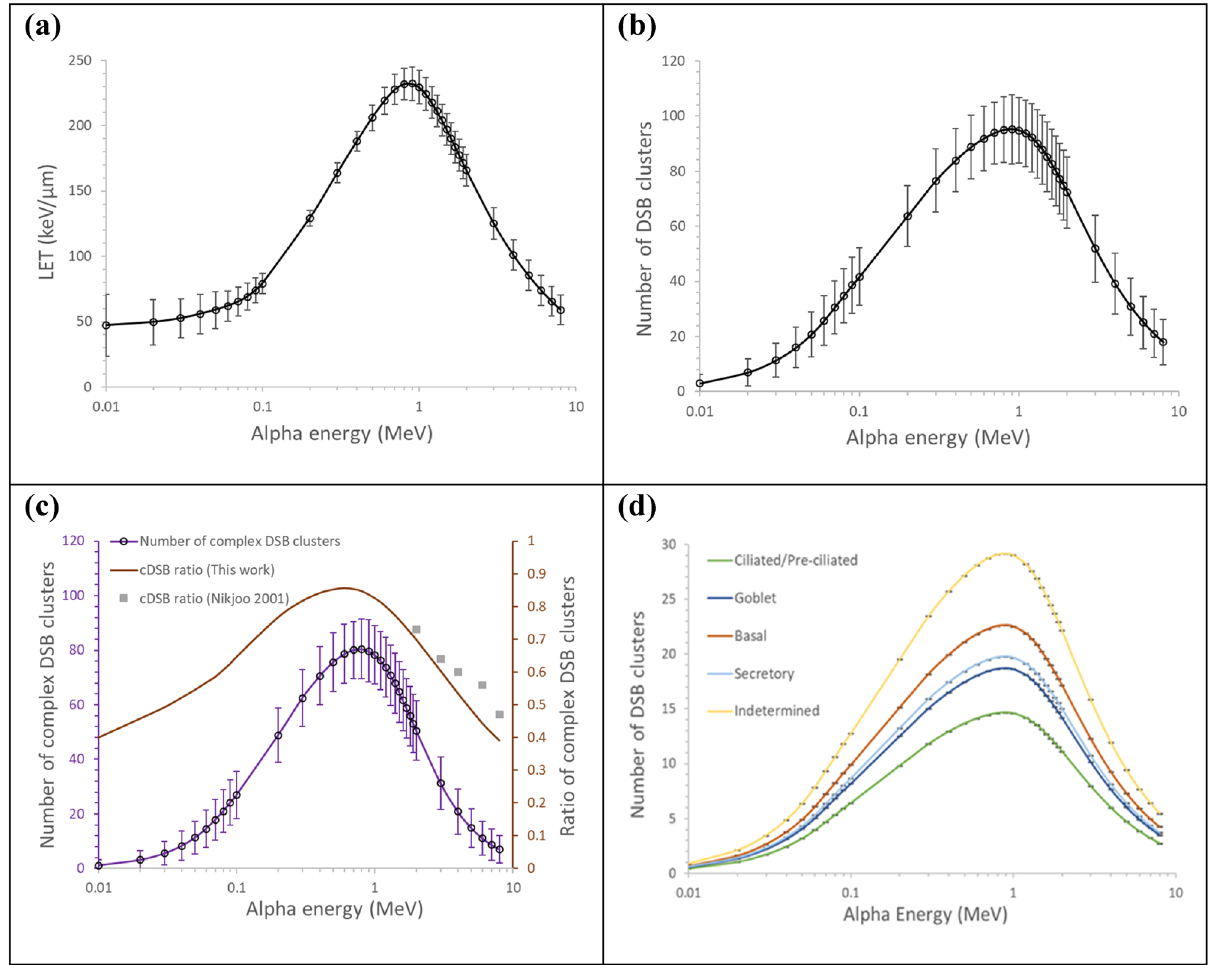
Figure 5. Results from Geant4-DNA simulation of energy deposition events in water medium followed by the DNA damage clustering over a 1 μm-thick volume segment: ( a ) LET, ( b ) the number of DSB clusters, ( c ) the number of complex DSB clusters and its ratio out of the total DSB clusters, and ( d ) the number of DSB clusters after applying the cell-specific volume fraction p F to the average values in ( b ). Each data point was obtained from the simulation of 10 4 alpha particles. Each bar in ( a – c ) indicated 1.96 standard deviation to imply 95% of confidence interval of the estimate. Each bar in ( d ) indicates one standard deviation of the mean